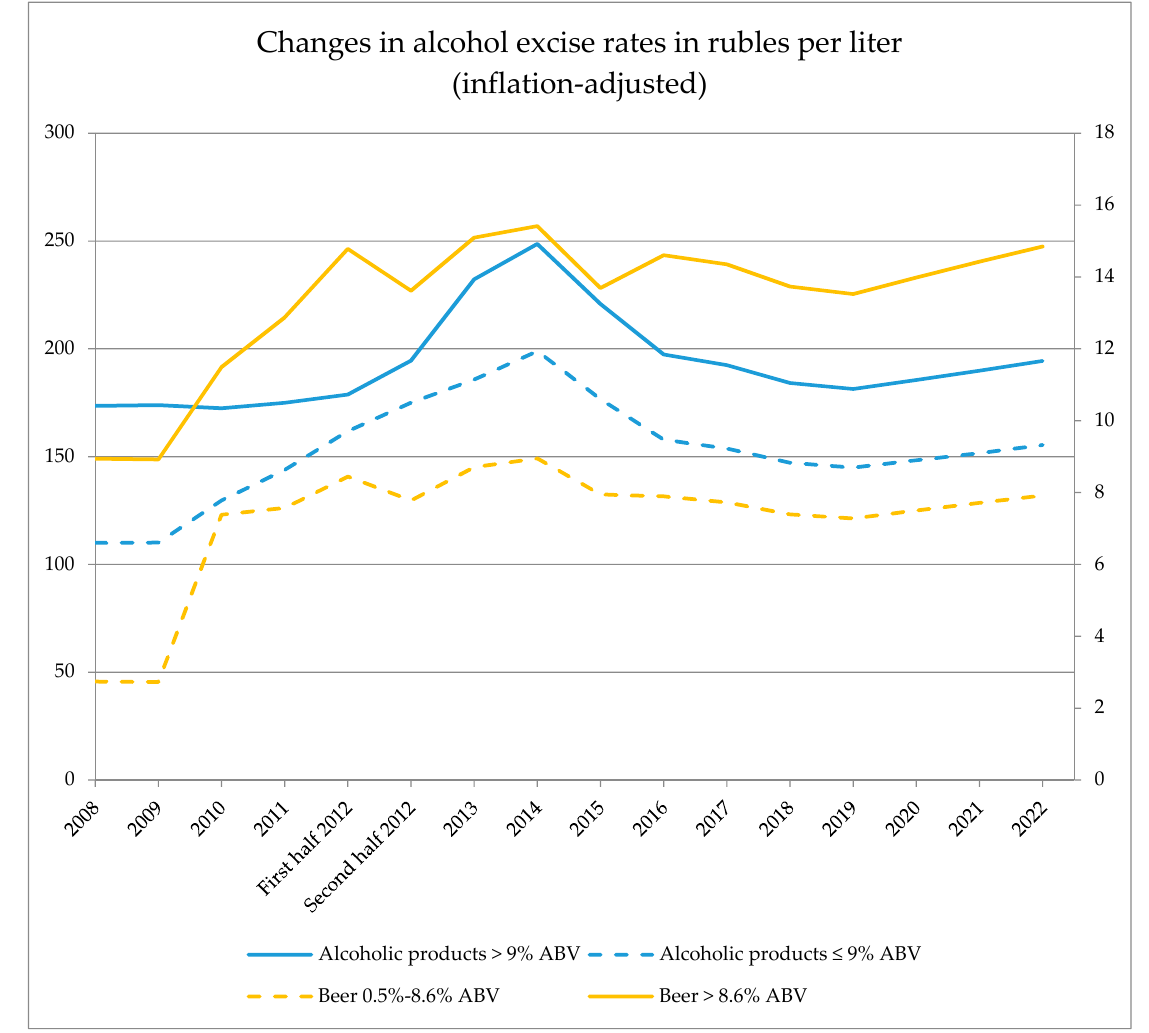
Figure 1. Changes in excise rates on different alcoholic beverages in rubles per liter, adjusted for inflation by using the annual consumer price index. Right scale: beer, left scale: other alcoholic products. Separate excise rates for wine and sparkling wine apply. See Appendix Table A4a, b for more details and an overview of non-adjusted excise rates. Sources: Tax Code of the Russian Federation and the Federal Statistical Service.